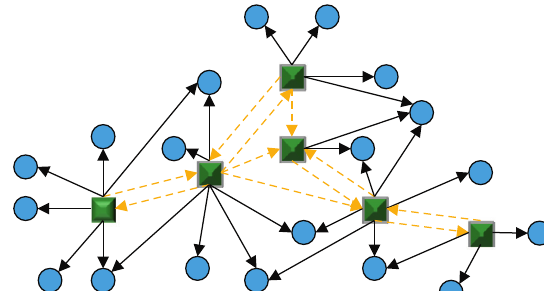
Figure 1: Simplified framework of two-layer bank-firm credit network. The green squares and the blue circles represent banks and firms, respectively. Meanwhile, connections of the black dashed lines and the yellow dotted lines represent the interbank credit and bank-firm credit, while the arrows mean the credit